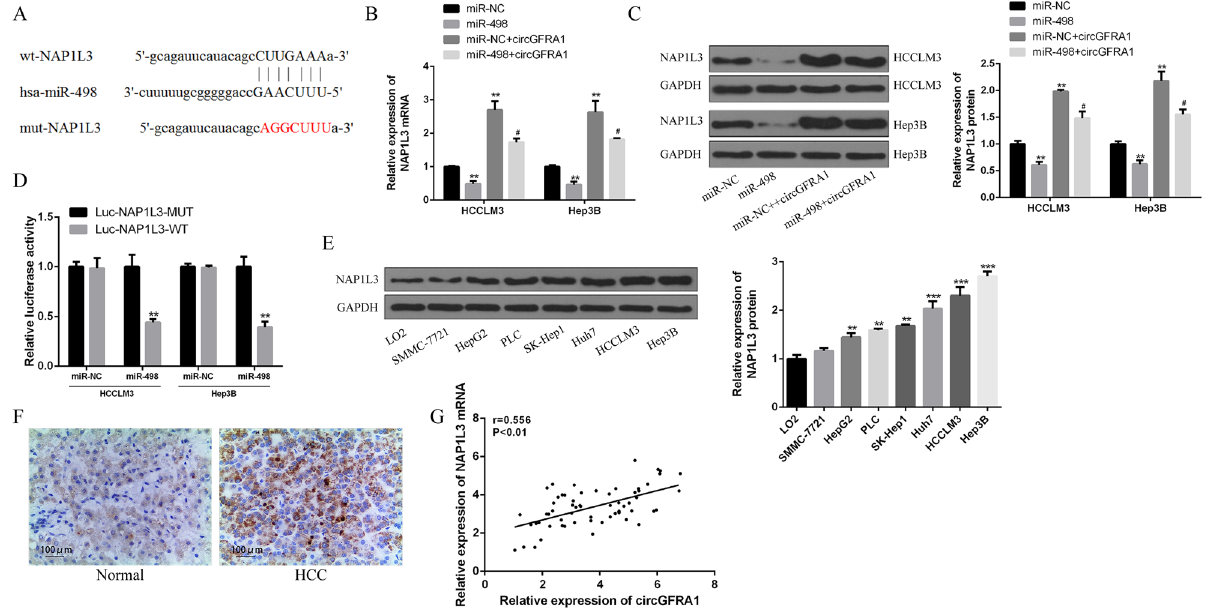
Figure 3. CircGFRA1 up-regulated NAP1L3 expression by sponging miR-498. ( A ) Putative binding sites of miR-498 and NAP1L3. ( B , C ) qRT-PCR and western blot for NAP1L3 mRNA and protein expression in HCCLM3 and Hep3B cells co-transfected with miR-498 mimics or miR-NC, and circGFRA1. ( D ) Luciferase activities in HCCLM3 and Hep3B cells co-transfected with miR-498 mimics and NAP1L3-WT or NAP1L3- MUT. ( E ) Western blot of NAP1L3 protein expression HCC cell lines and normal liver cell line. ( F ) IHC staining of NAP1L3 in HCC tissues and normal tissues. ( G ) Pearson’s correlation between circGFRA1 and NAP1L3 in HCC tissues (n = 62). *vs. control group, # vs. miR-498 mimics group. **P < 0.01, # P <